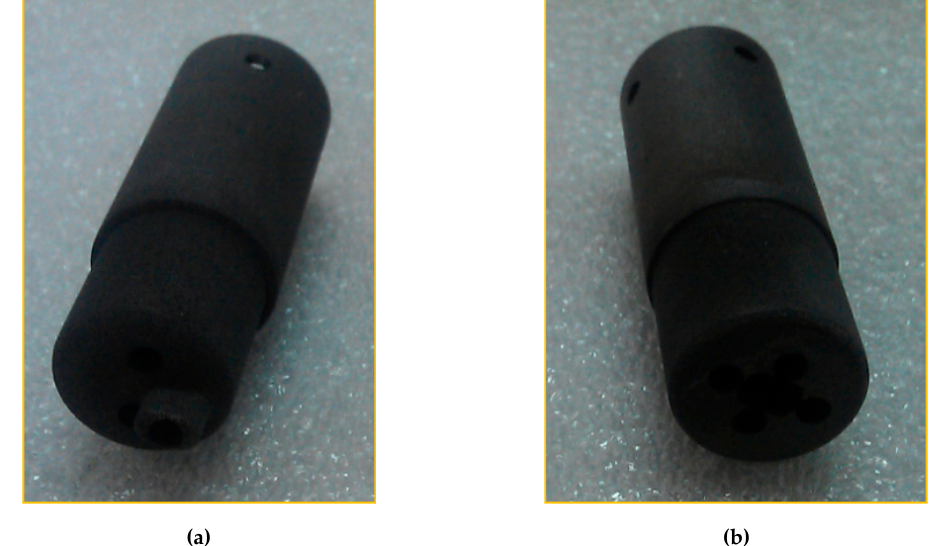
Figure 5. The two graphite probe casings from the Experimental Advanced Superconducting Tokamak (EAST) Group, each with a diameter of 3 cm and overall lengths of 10 cm, shown here without the probe pins inserted, i.e., as they were introduced into the UNCD coating device in Innsbruck: ( a ) the probe casing for three Langmuir probe pins); ( b ) the probe casing for the 5-pin Mach probe.